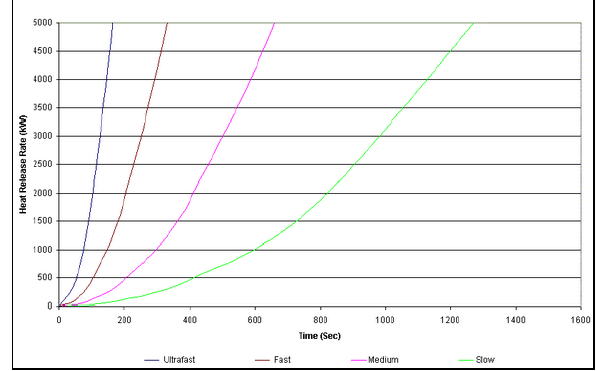
Figure 1. NFPA fire growth rate